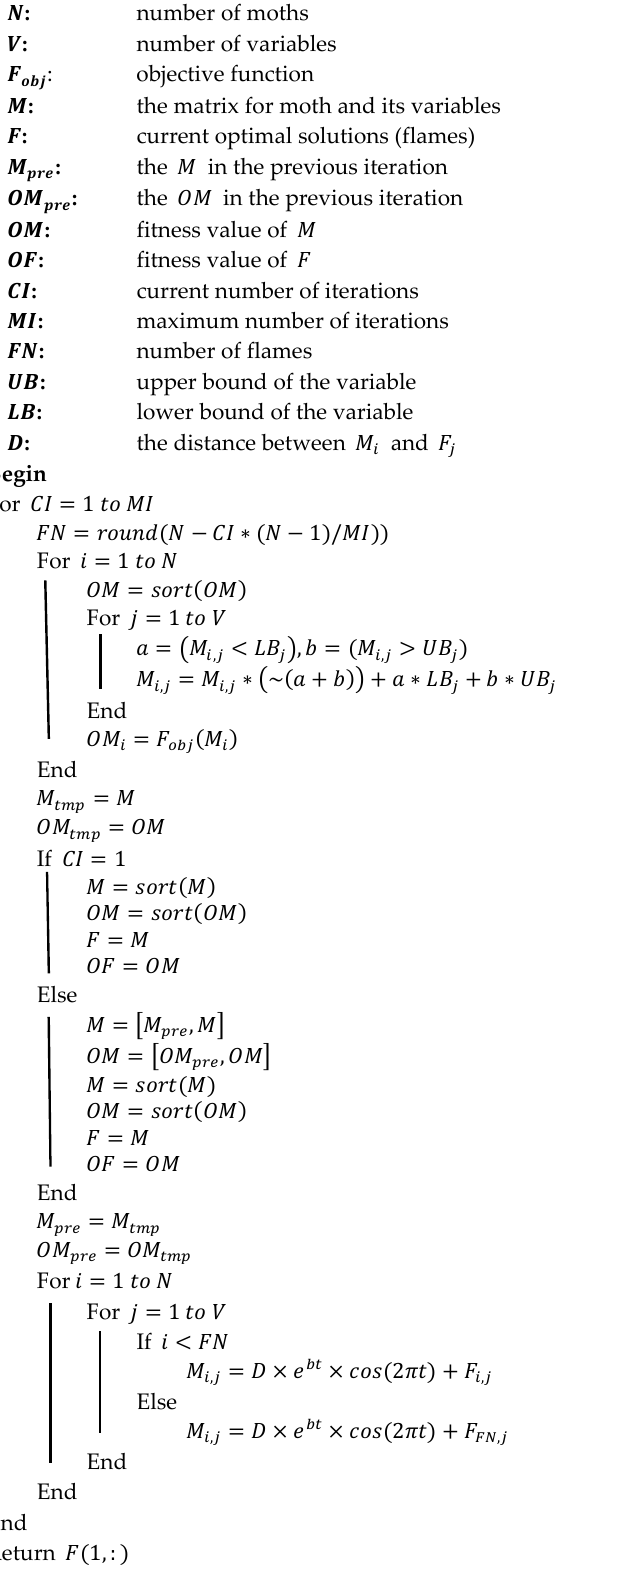
Algorithm 1 MFO Algorithm